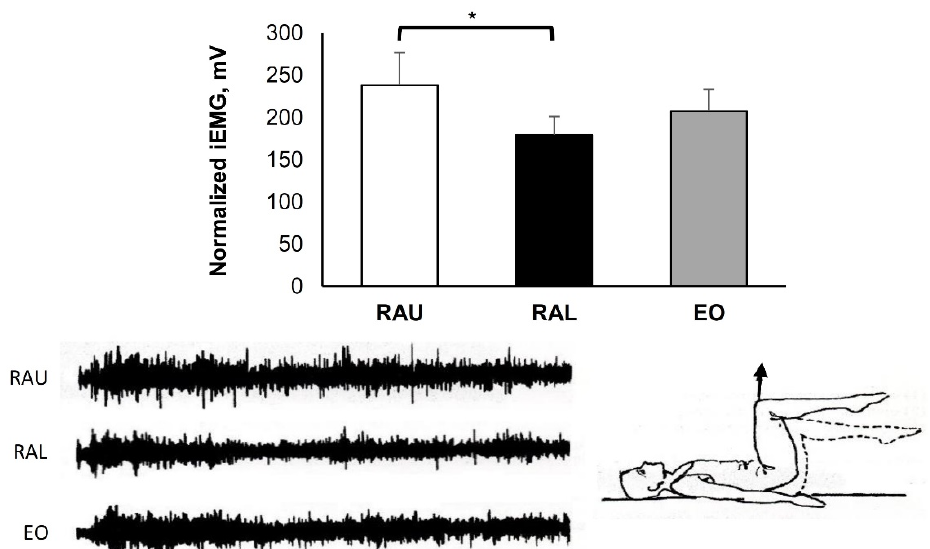
Figure 6. Hips and knees flexed 90 ◦ . Posterior pelvic tilt and lifting up the hips (see arrow) with isometric contraction for 10 s. Group mean electric activity during the exercise. iEMG indicates surface electric activity. Raw EMG activity of the three muscles from one participant. RAU = rectus abdominis upper part; RAL = rectus abdominis lower part; EO = external oblique. Differences between muscles: * p < 0.05. Figure 7: Starting position: Hook lying with knees flexed (110 ◦ ). The unsupported